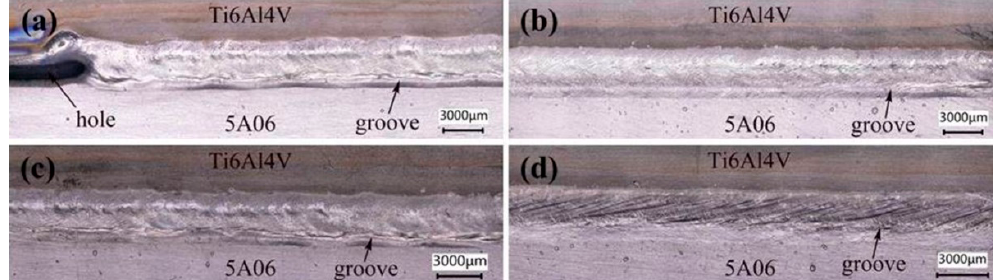
Figure 7. The influence of the welding speed on weld seam appearance: ( a ) 8 mm/s; ( b ) 9 mm/s; ( c ) 10 mm/s; ( d ) 11 mm/s.